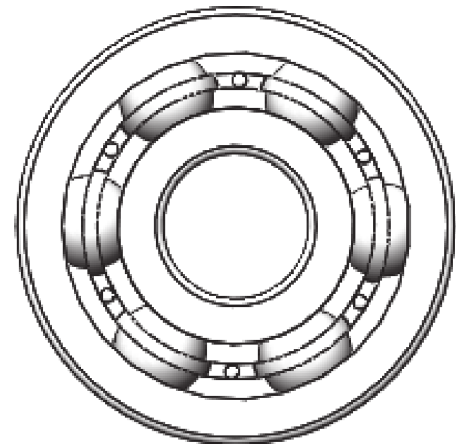
Figure 3: Rolling bearing